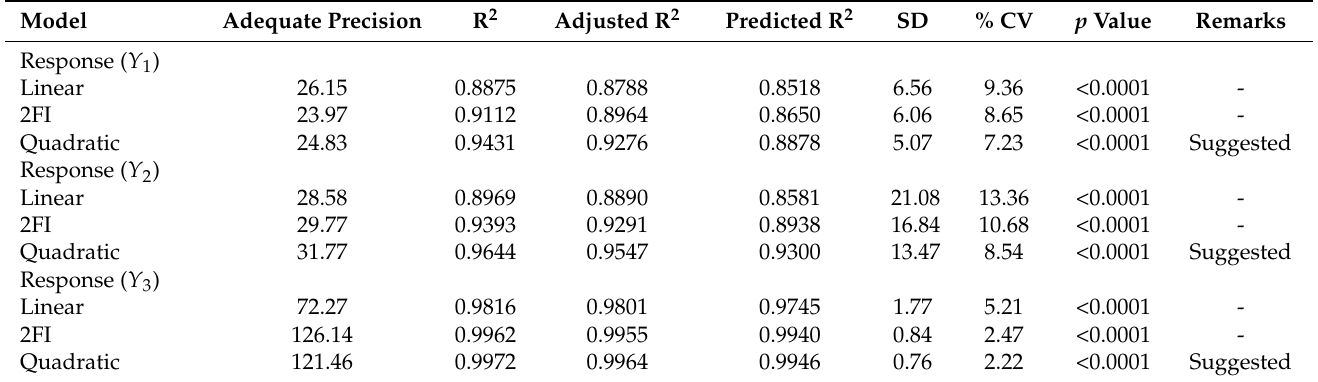
Table 3. Regression analysis results for responses Y 1 , Y 2 , and Y 3 for fitting data to different